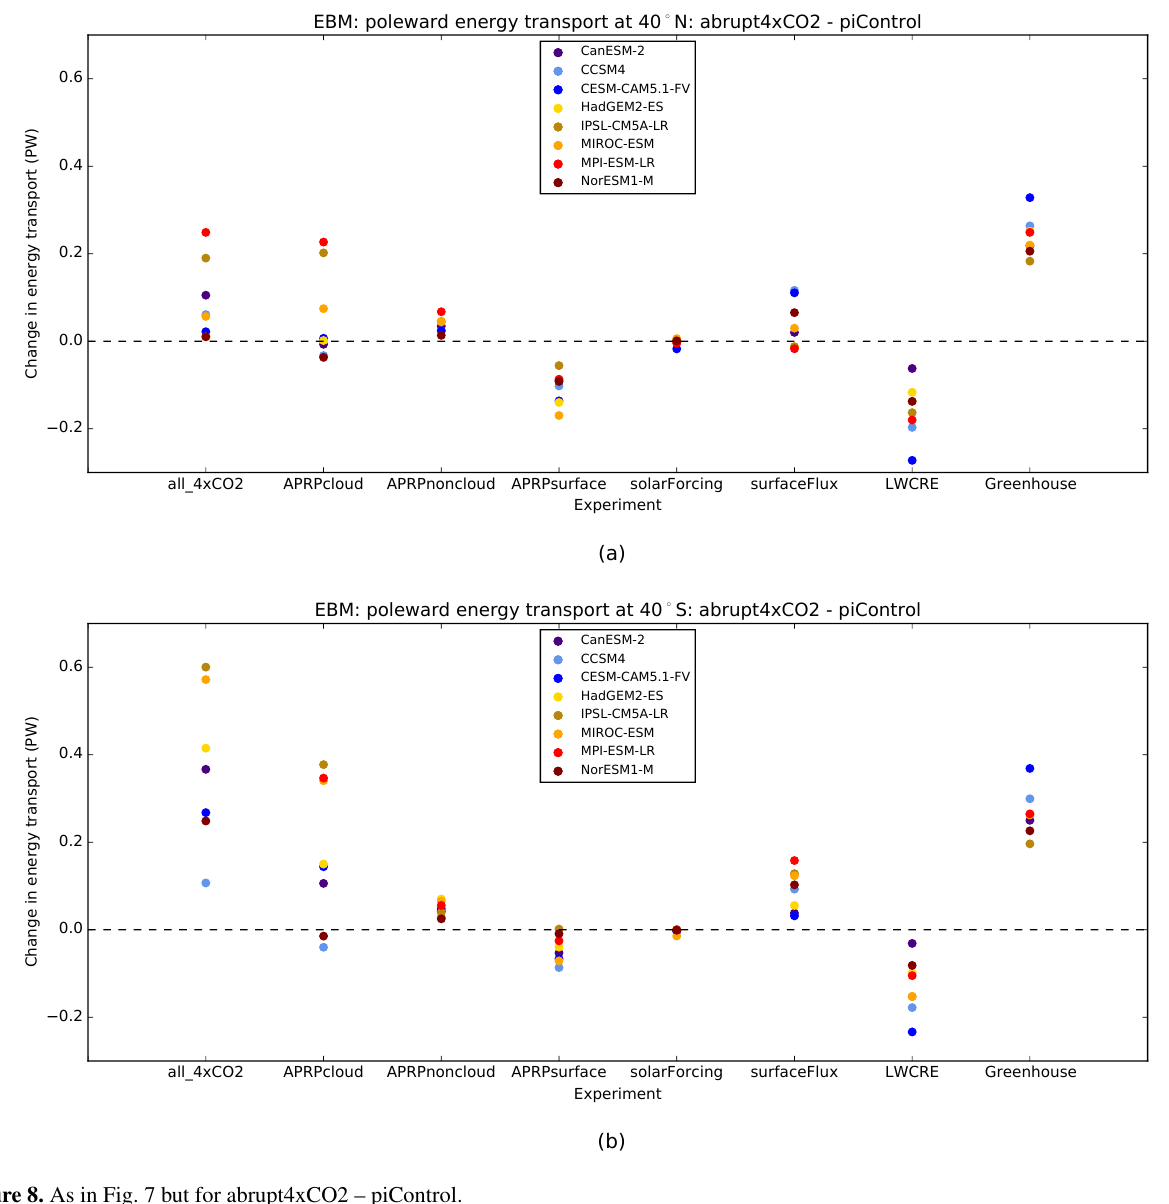
Figure 8. As in Fig. 7 but for abrupt4xCO2 – piControl.